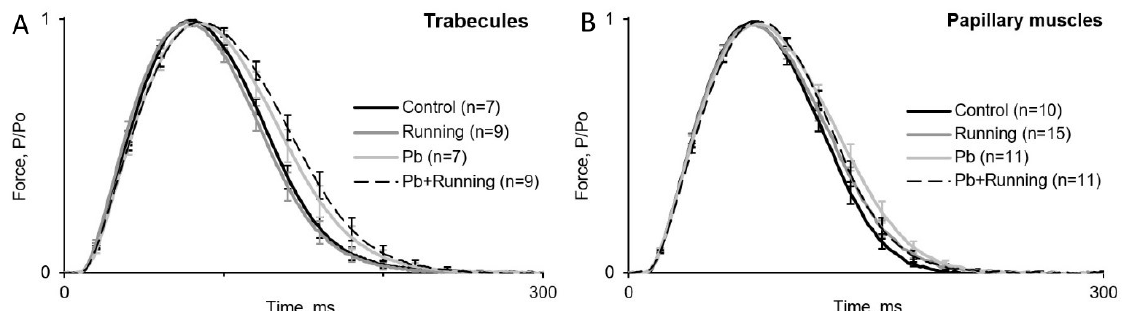
Figure 1. Superposition of the force development time course for steady-state isometric contractions of right ventricular trabecules ( A ) and papillary muscles ( B ) from male rats of the control group and the three exposed groups (here and in the following figures, designations are given in the legend, and the number of preparations is given in brackets). Force is given in units normalized to amplitude. Muscle length is 95% Lmax .